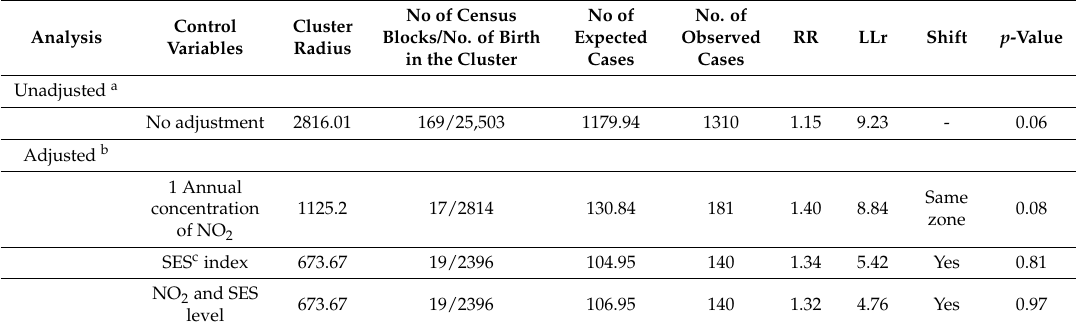
Table 1. Summary statistics of the most likely clusters of preterm birth risk and spatial relocation resulting from the adjustment